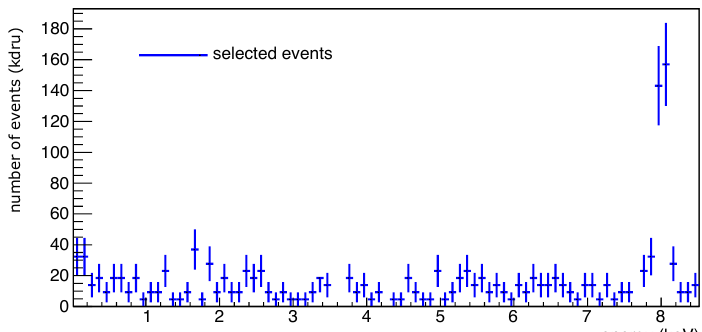
Figure 18: Measured spectrum of the Skipper-CCD experiment, after applying selec- tion